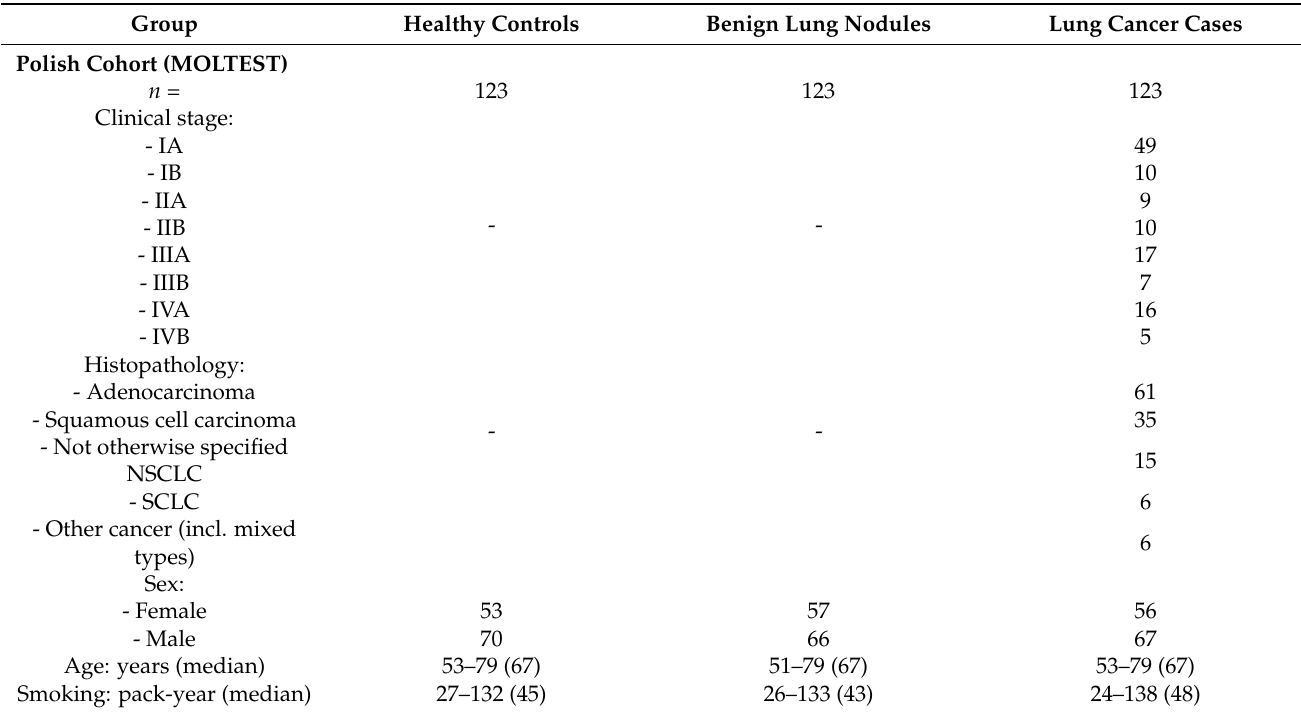
Table 1. Characteristics of donor